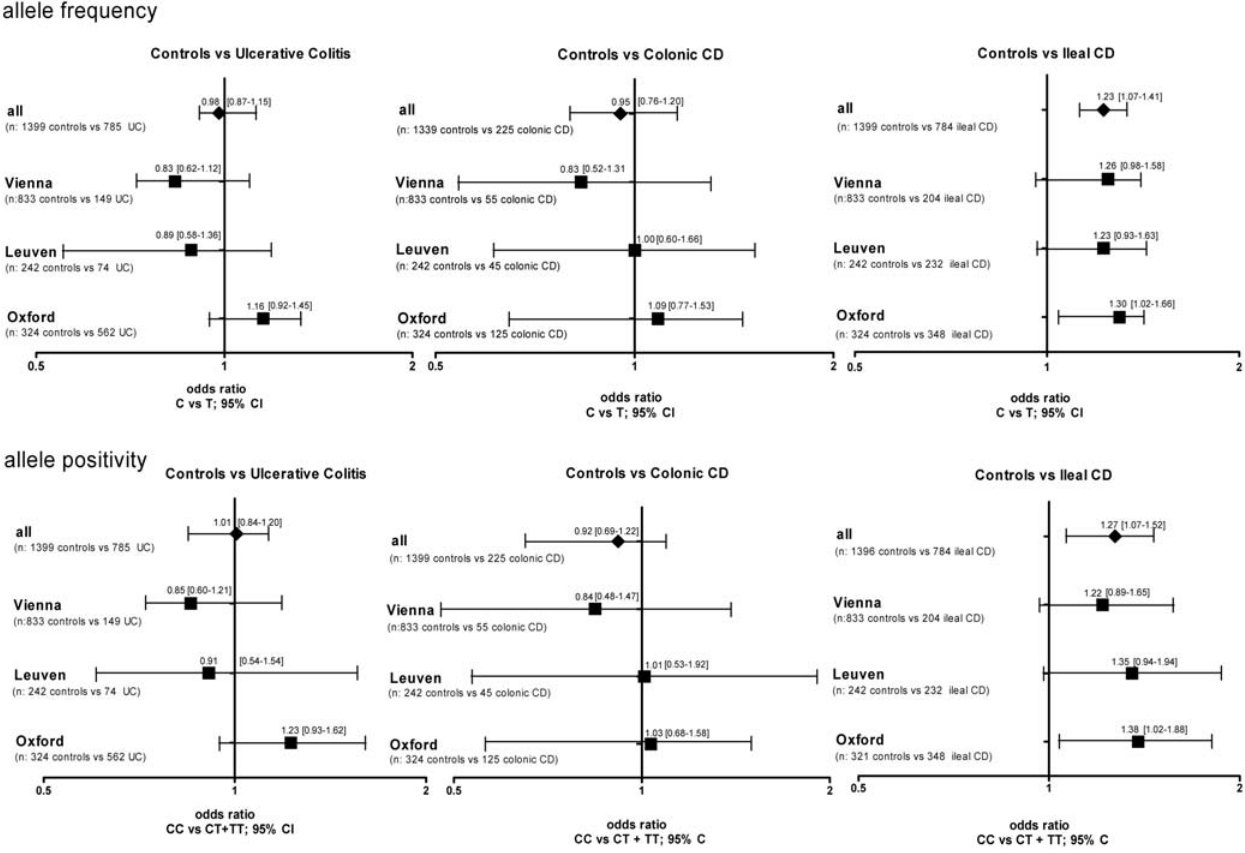
Figure 3. Differences in frequency distribution of rs3814570 in the different disease subgroups compared to healthy controls. Odds ratios and confidence intervals for the different comparisons are shown. The frequency distribution of rs3814570 was analyzed in different cohorts and combined samples: odds ratios and 95% confidence interval for allele frequency (upper panel) and allele positivity (amount of all T- allele carriers, lower panel) are shown for patients with ulcerative colitis (UC) (left panel), Crohn’s disease (CD) patients with solely colonic involvement (L2, middle panel) and finally patients classified as either L1 (solely ileal) or L3 (ileal and colonic involvement) (right panel) compared to healthy control individuals.